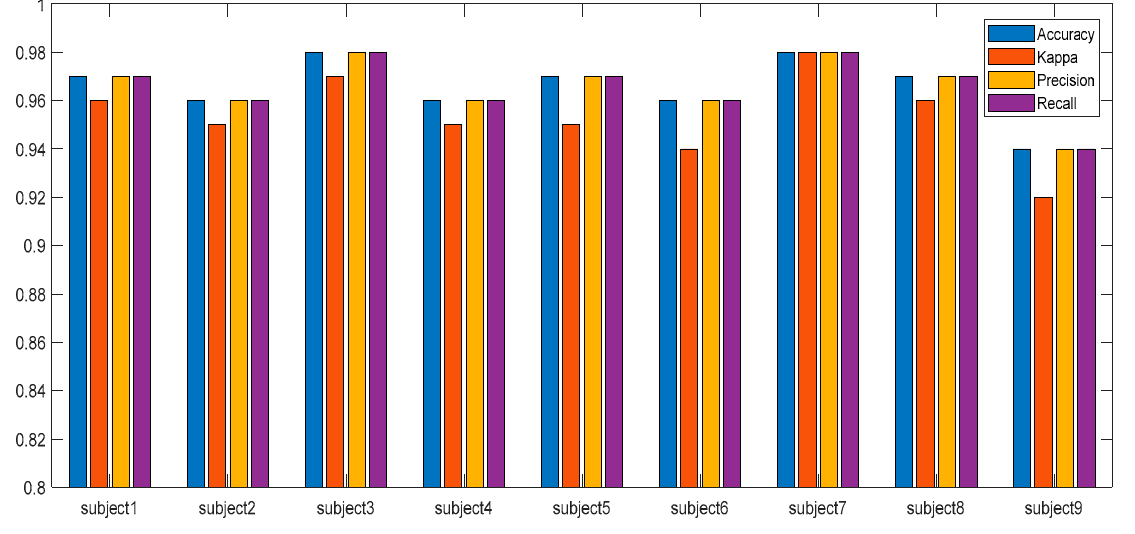
Figure 6. Index of classification result of 250win-OB.